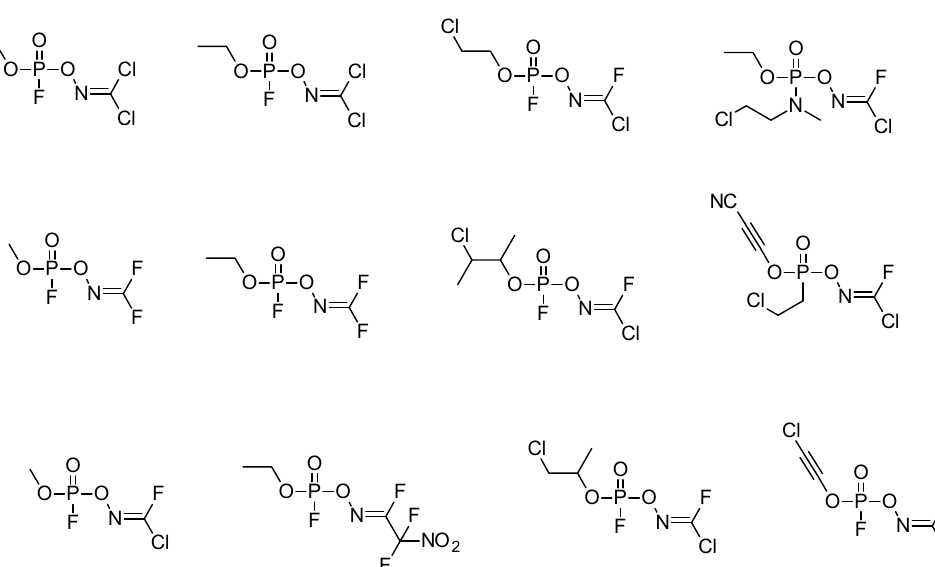
Figure 4. Possible structures of A-series nerve agents, as reported by Ellison [14] and Patocka [13].